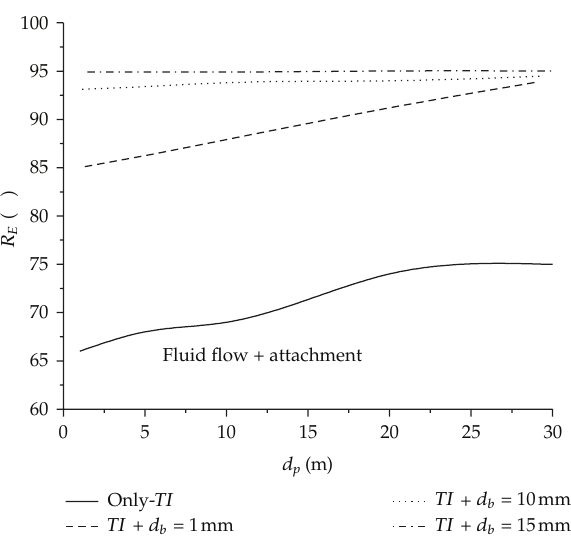
Figure 10: Non metallic Inclusion removal rate considering the sum of the fluidynamics e ff ect and the bubble